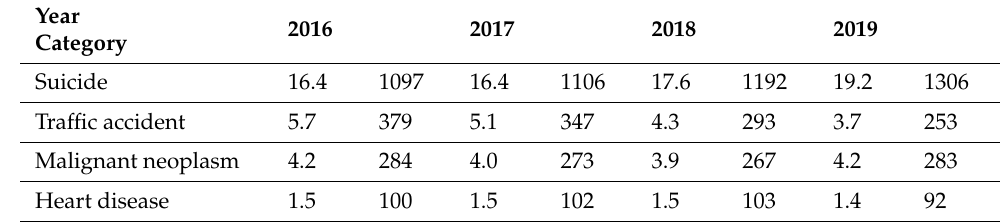
Table 1. 2016–2019 Statistics on the cause of death in the 20s (unit: Death rate (per 100,000 people),